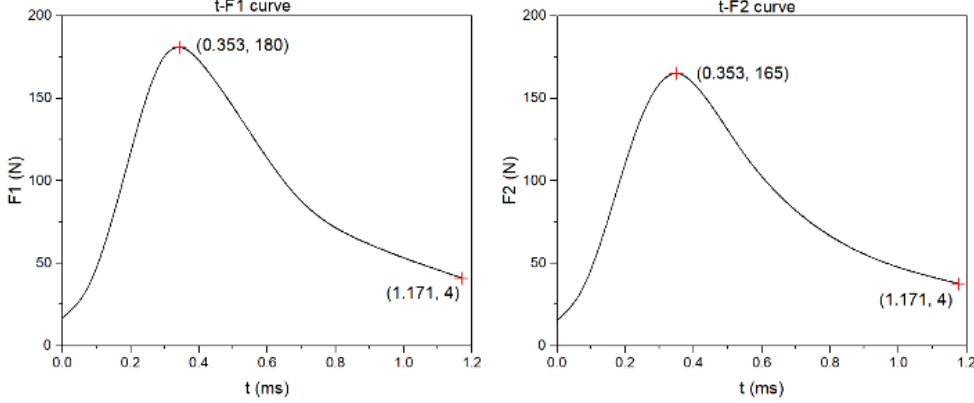
Figure 8. Lateral force F 1 and axial force F 2